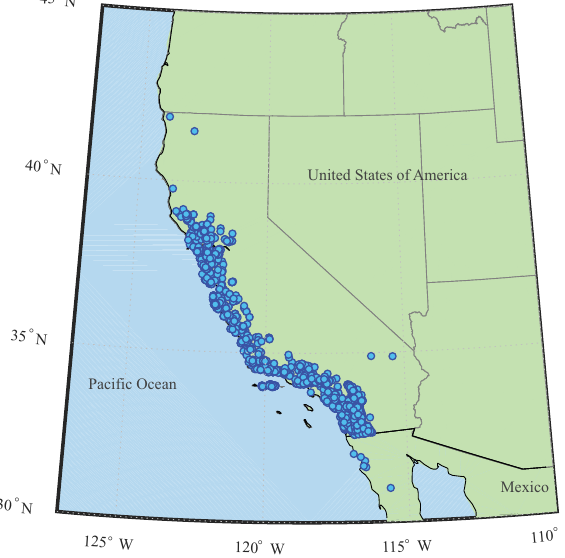
Figure 1. Species distribution map of Quercus agrifolia . Each dot represents an observation of Q. agrifolia occurrence. Data provided by the participants of the Consortium of California